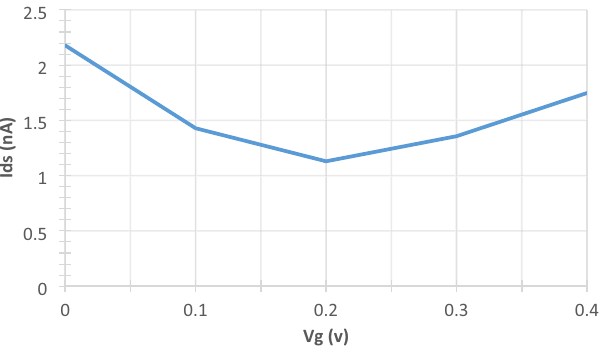
Figure 10. Transfer curve of the G-FET sensor at V ds = 0.05 V. Produced by Excel based on the data generated from QuantumATK